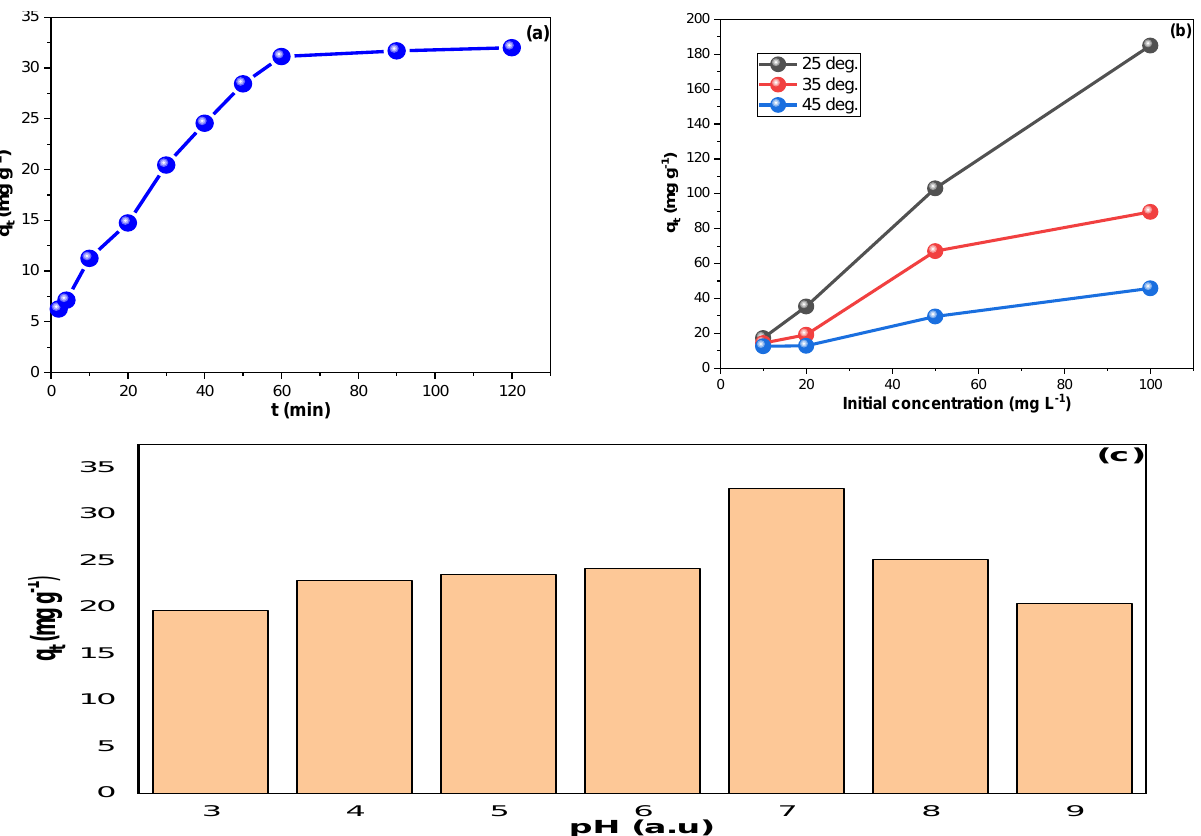
Figure 5. The influence of ( a ) contact time, ( b ) concentration at different temperatures, and ( c ) pH on the adsorption of IC on BiOI nanoparticles.